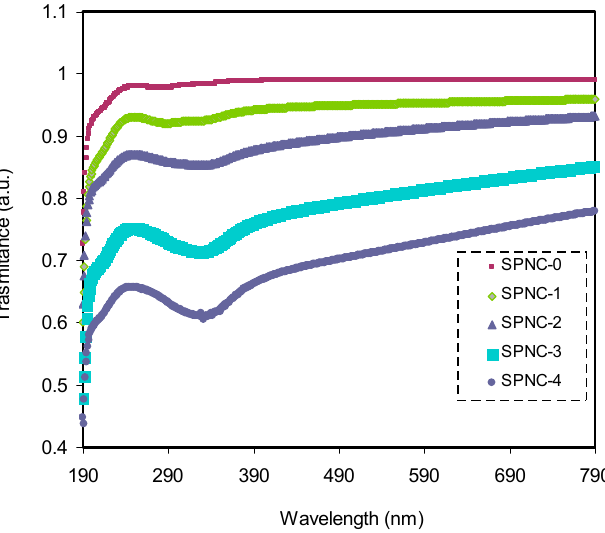
Figure 4. Variation in transmittance spectra for pure and CeO 2 -doped samples. Figure 3. Variation in transmittance spectra for pure and CeO 2 -doped samples.